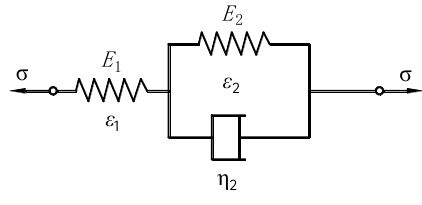
Figure 7. A standard linear solid model.